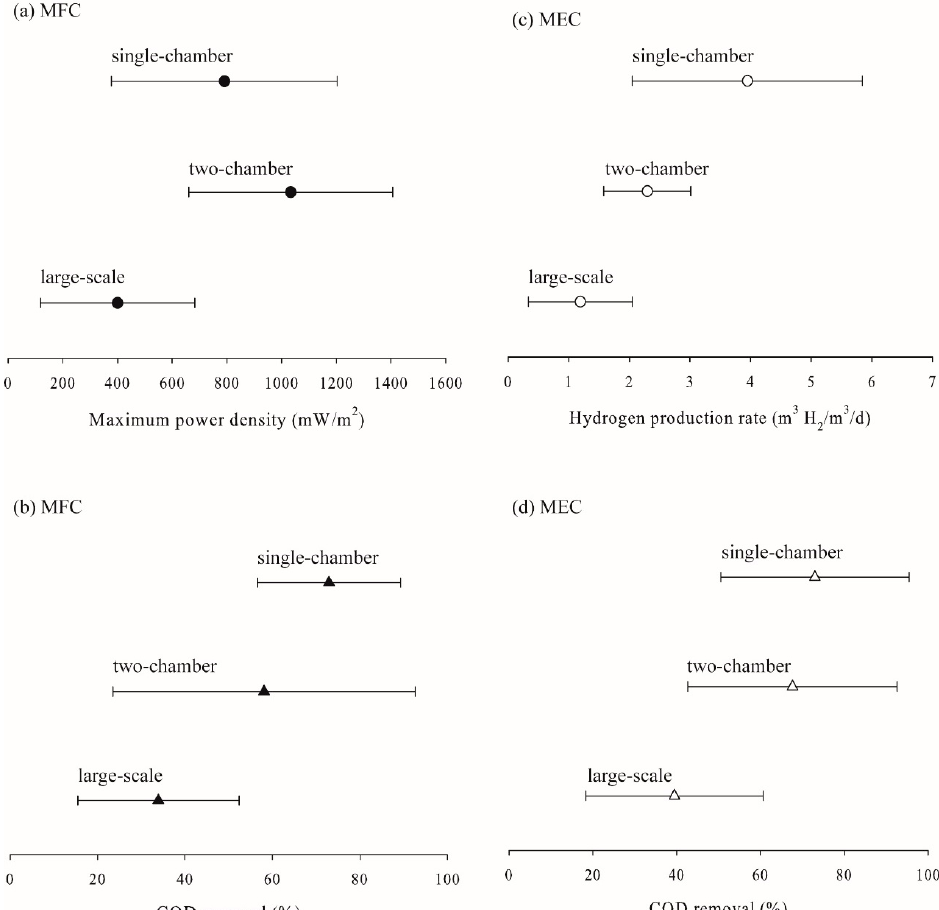
Figure 7. Influences of reactor configuration on ( a ) MFCs’ power generation, ( b ) MFCs’ COD removal, ( c ) MECs’ hydrogen production, and ( d ) MECs’ COD removal.